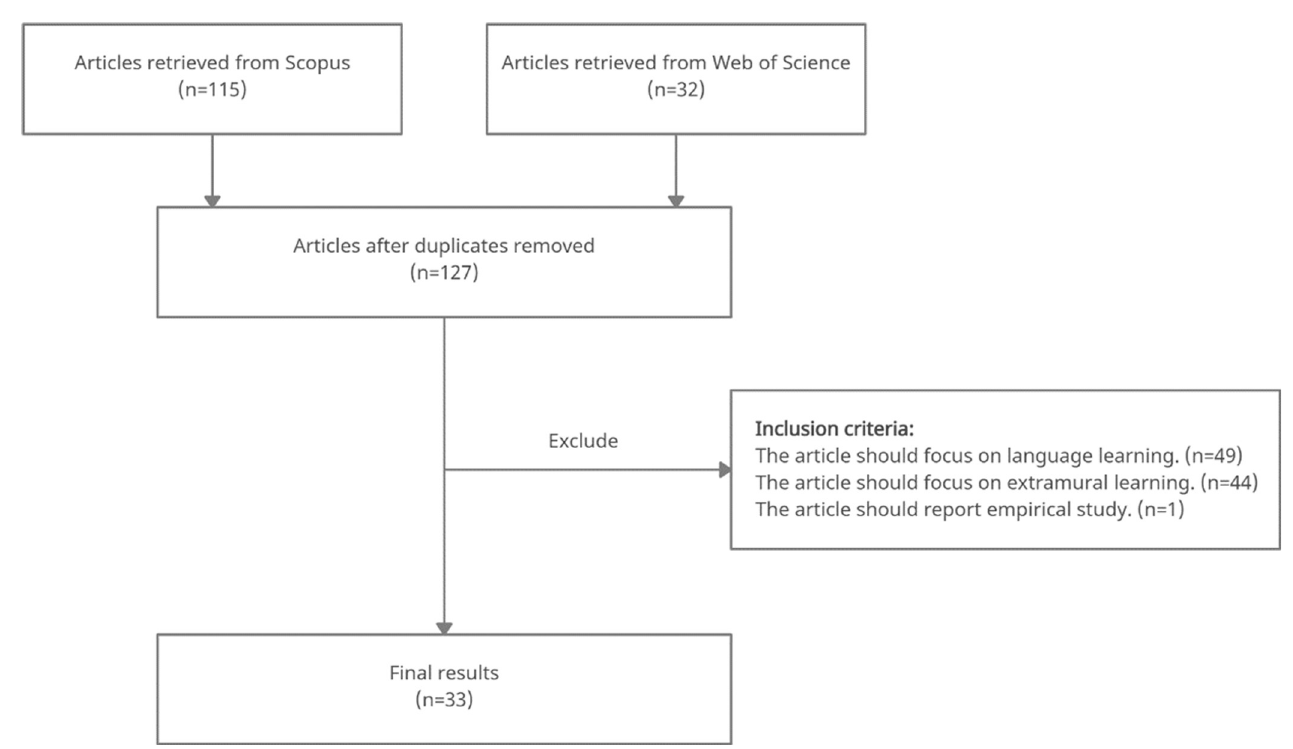
Fig 1. Process of data